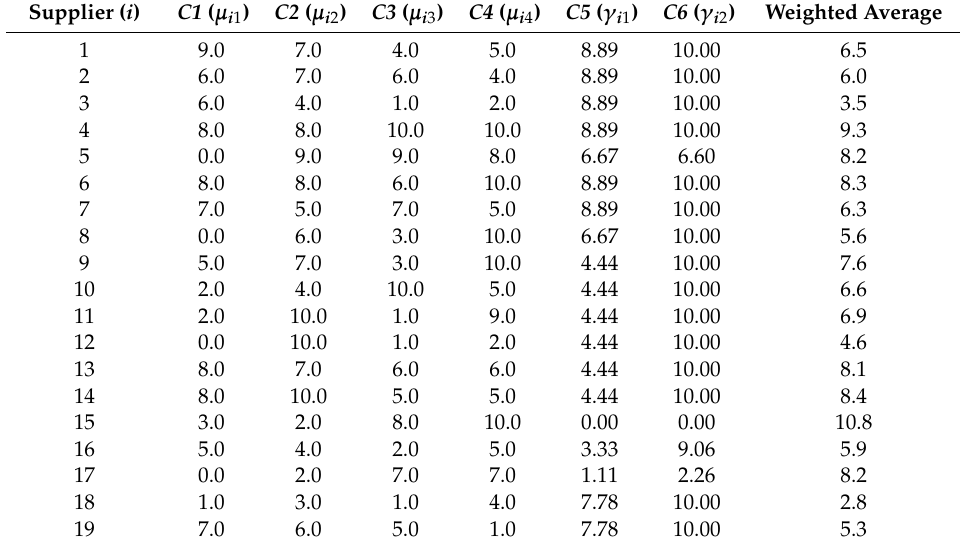
Table 1. Prior rating information matrix of L Electronics’ connected nodes.